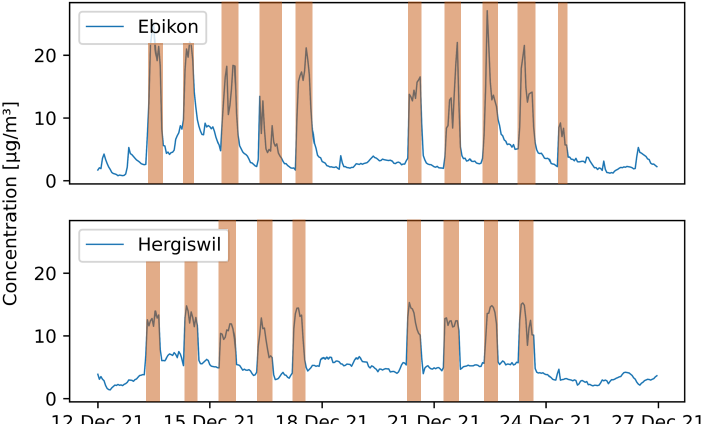
Figure 16. PM 10 hourly mean data recorded with mobile pilot sensor-boxes located in Ebikon and Hergiswil in the period from 12 December 2021 to 27 December 2021. Periods where the vehicle is in operation are marked in red.